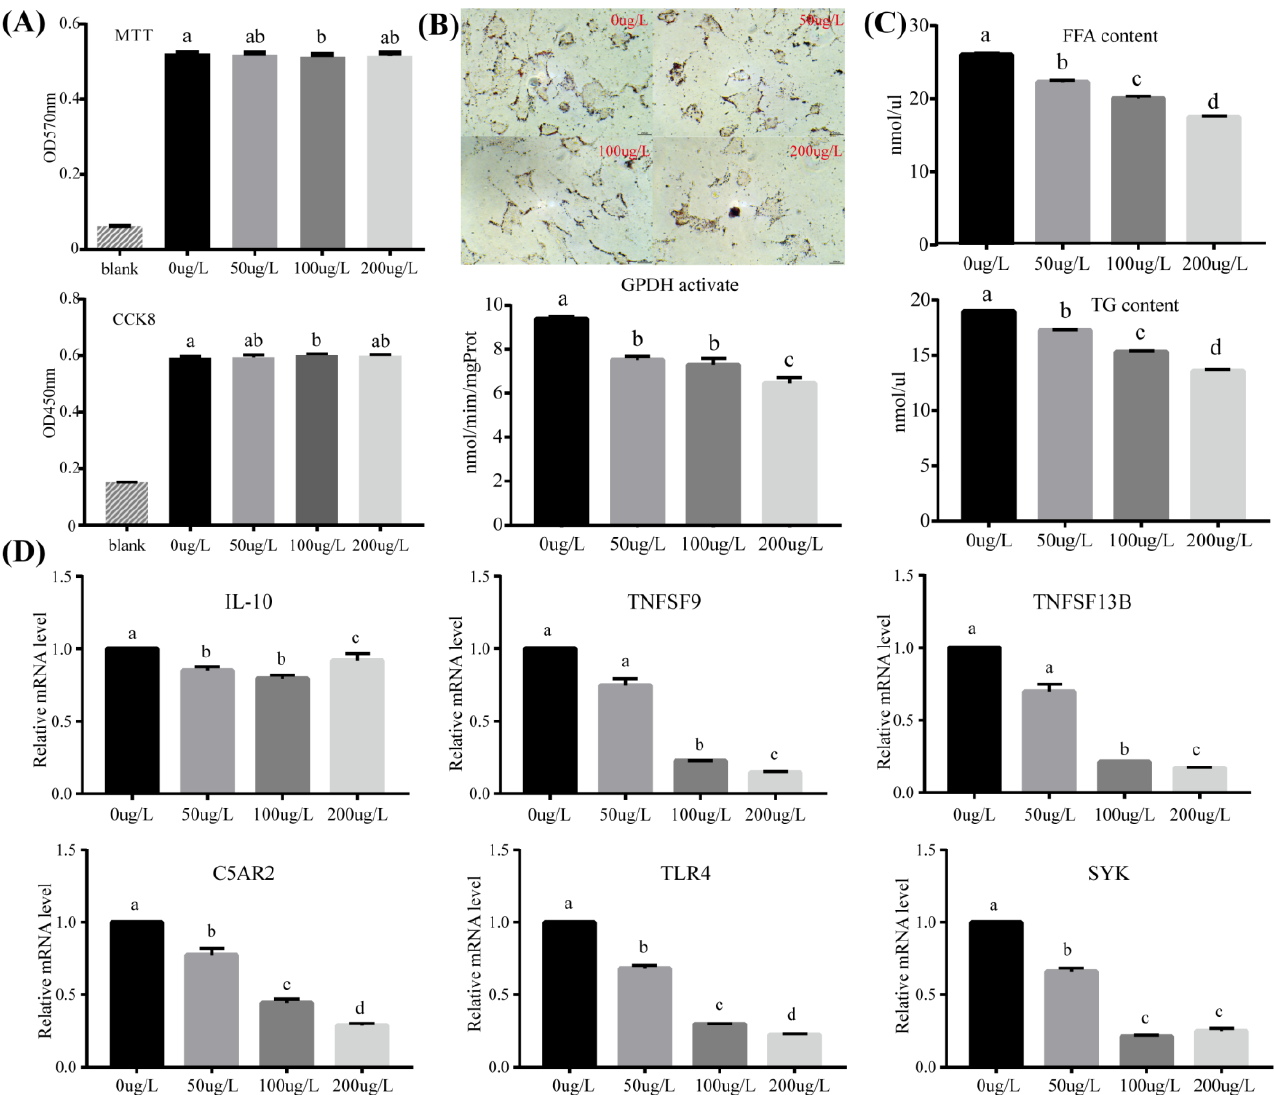
Figure 5. Effects of Agriophyllum squarrosum extract on lamb-adipocyte tissue: ( A ) proliferation; ( B ) differentiation; ( C ) lipid metabolism; and ( D ) immune and inflammatory responses for selected genes. Means with different letters differ from each other p < 0.05.